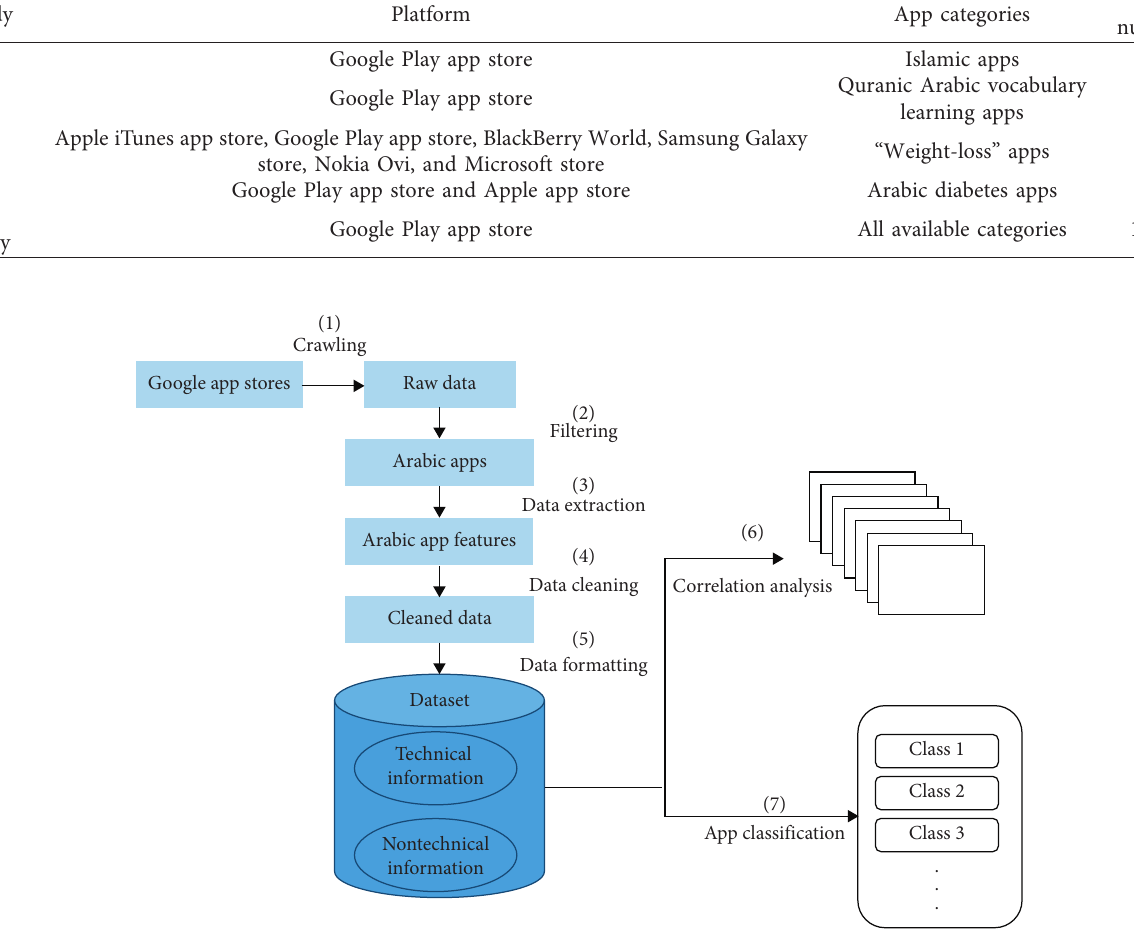
Figure 1: Overall app analysis of Arabic apps in Google Play app store. A seven-phase approach, including crawling, filtering, data extraction, data cleaning, data formatting, statistical analysis, and app classification.